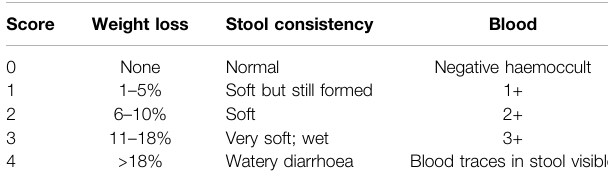
TABLE 1 | Scoring system for calculating DAI